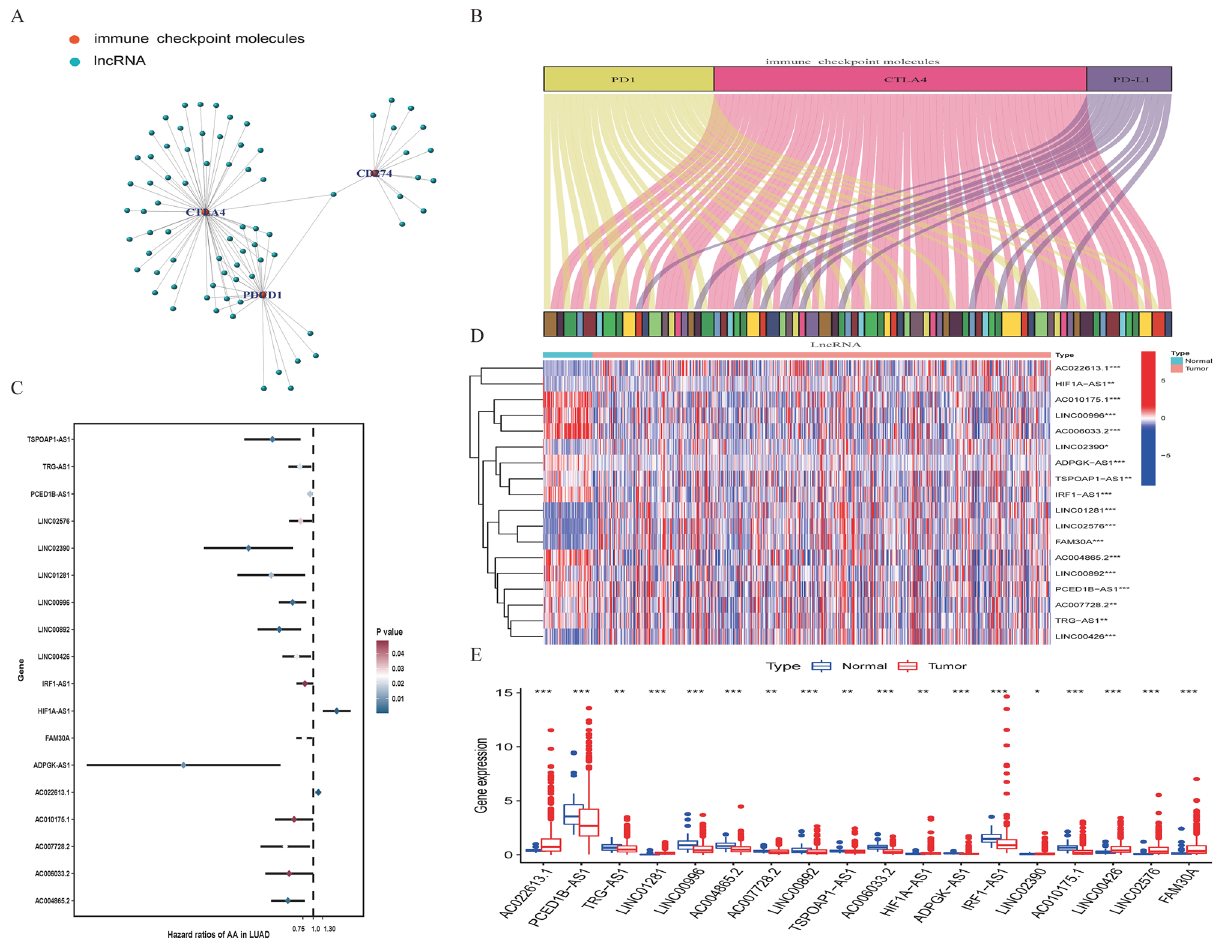
Figure 1. Identification of IClncRNAs of prognostic value in patients with LUAD. ( A ) Network diagram for PD1, PD-L1, CTLA4 and 75 IClncRNAs. ( B ) Sankey relational diagram for three immune checkpoint genes and the IClncRNAs. ( C ) Univariate Cox regression analysis revealed that the 18 selected lncRNAs were significantly correlated with the clinical prognosis. ( D ) Heatmap for the expression difference of IClncRNAs between tumour and normal tissue. ( E ) Boxplot for the expression difference of IClncRNAs between tumour and normal tissue (* P < 0.05, ** P < 0.01, *** P < 0.001, **** P <